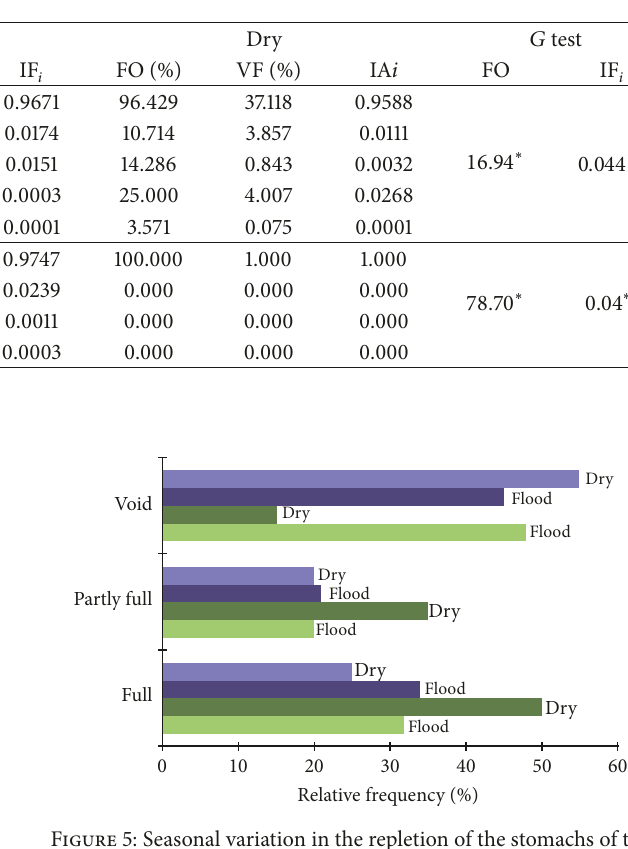
Figure 5: Seasonal variation in the repletion of the stomachs of the S. gibbus (blue) and S. rhombeus (green) specimens collected in the Coaracy Nunes reservoir in Ferreira Gomes, Amap´a